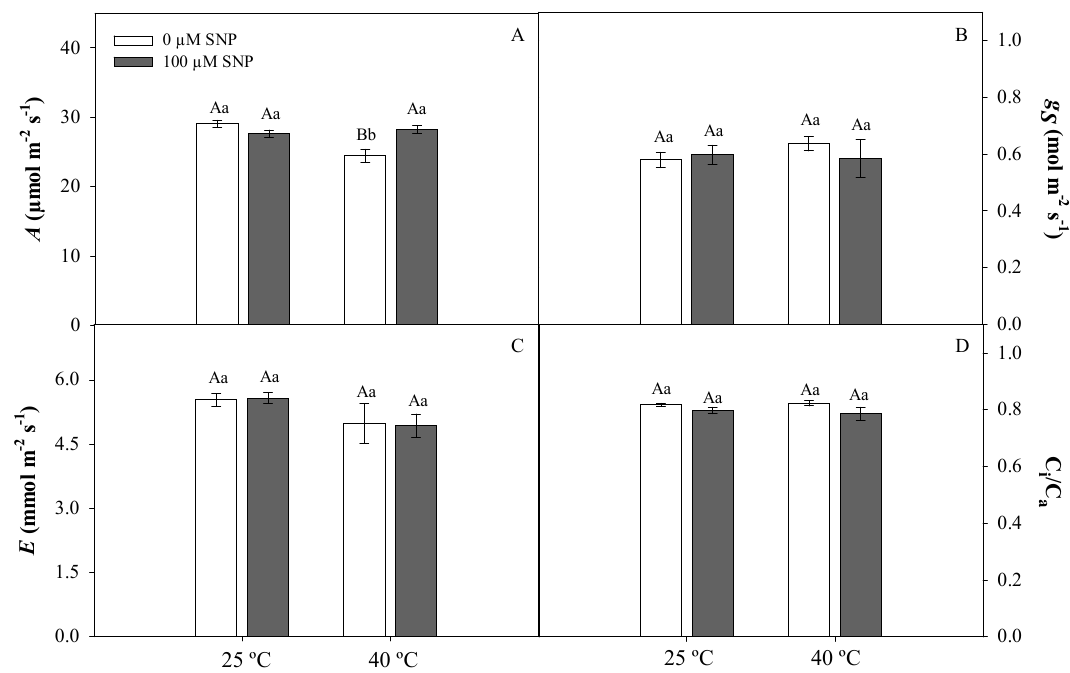
Figure 4. Photosynthetic rate ( A , A ), stomatal conductance ( g s , B ), transpiratory rate ( E , C ), and ratio between internal and external CO 2 ( Ci/Ca , D ) in soybean plants submitted to two temperatures (25 °C and 40 °C) and two SNP concentrations (0 and 100 μ M). Bars represent means ( n = 5) ± SE. Capital letters (between temperatures) and lowercase letters (within temperatures) represent significant differences using Tukey’s test ( p < 0.05).